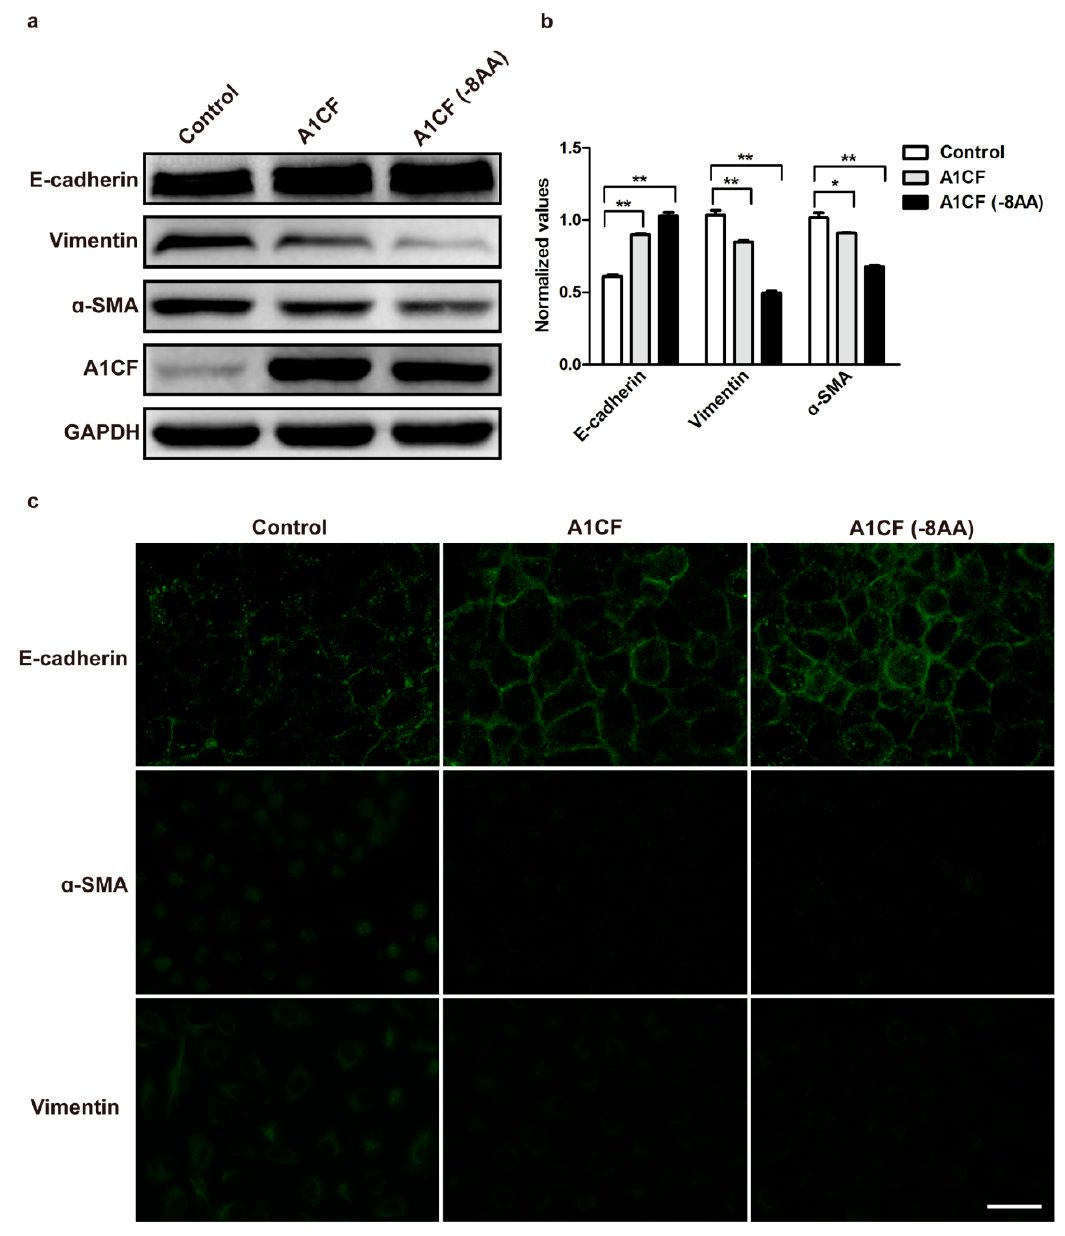
Figure 3. Ectopic expression of A1CF inhibits EMT. ( a ) Overexpression A1CF and A1CF (-8AA) both